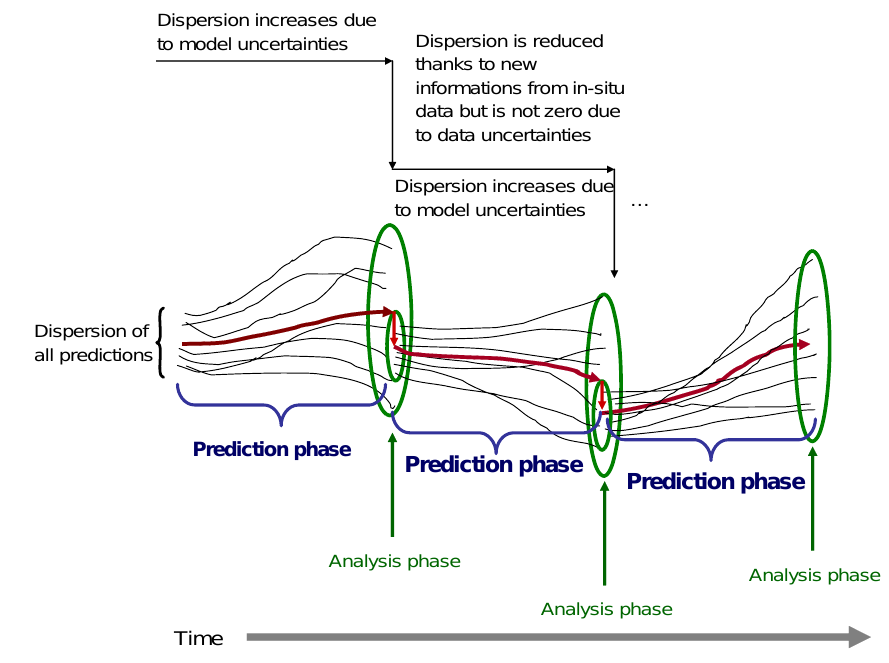
Fig. 6. A schematic view of the ensemble Kalman